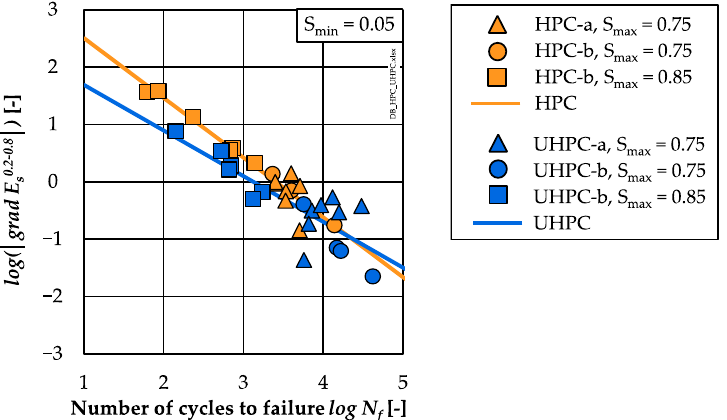
Figure 8. Log. gradients of stiffness in phase II ( log(|grad E s 0.2–0.8 | ) related to log. numbers of cycles to failure of HPC and UHPC.